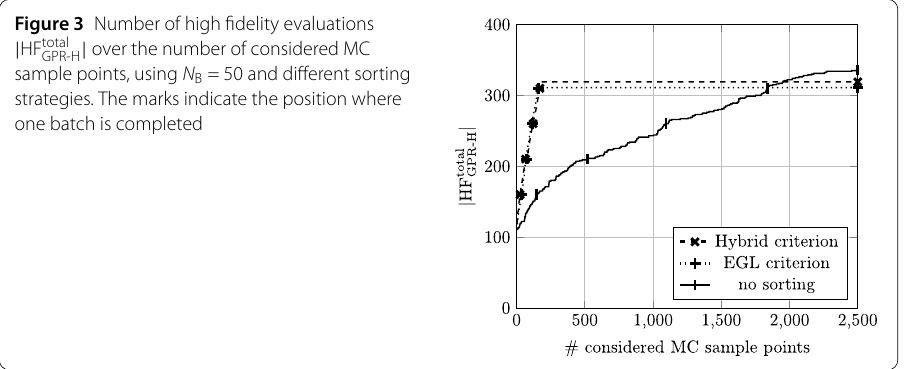
Figure 3 Number of high fidelity evaluations | over the number of considered MC | HF total GPR-H sample points, using N B = 50 and different sorting strategies. The marks indicate the position where one batch is